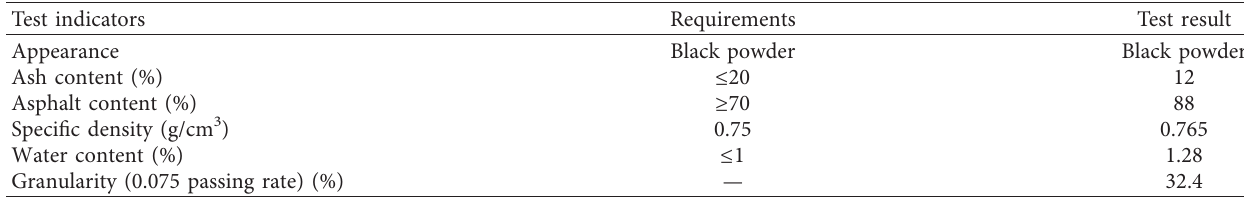
Table 3: Properties of UM asphalt.